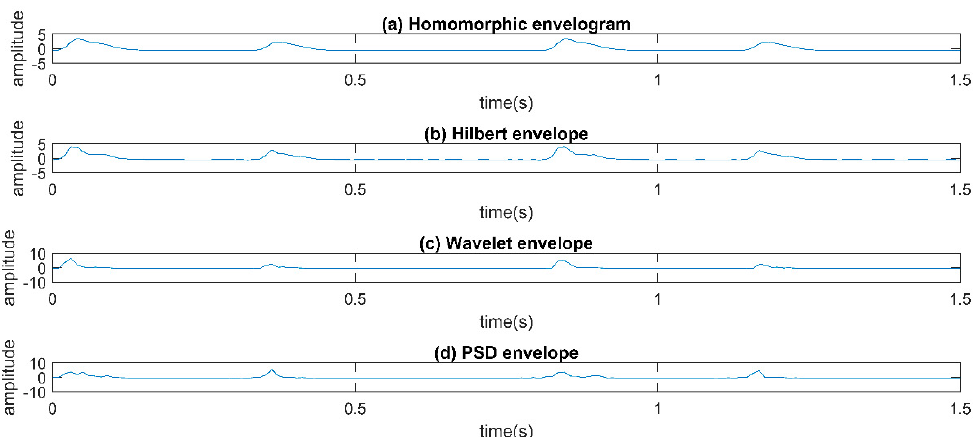
Figure 9. An example of the envelope extracted from a heart sound signal with a fixed length, which contains the following four heart sound features: Homomorphic envelogram, Hilbert envelope, Wavelet envelope, and PSD (Power Spectrum Density) envelope.